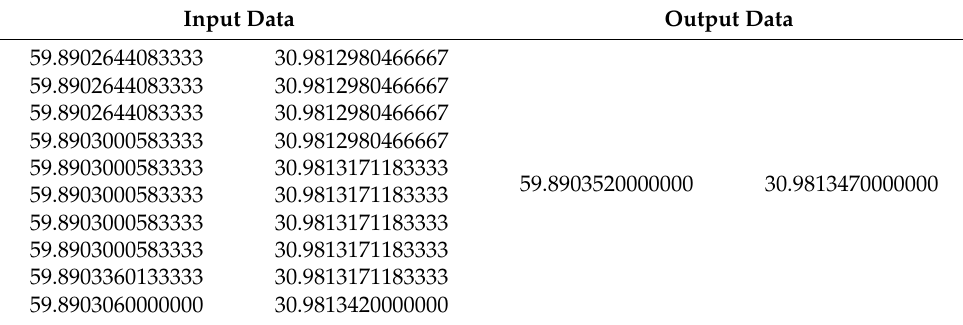
Table 4. Results of the second neural